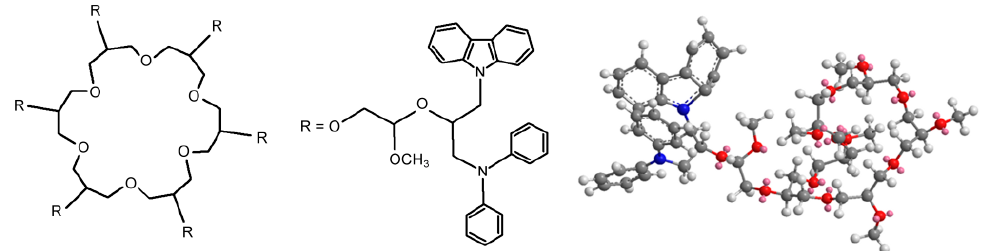
Figure 6. Structures of studied polymer—AP I Mn = 5300, D = 1.40.